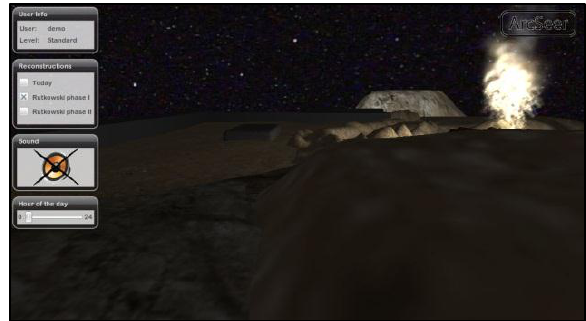
Figure 9: Night-time scene in the ArcSeer Petsofa project